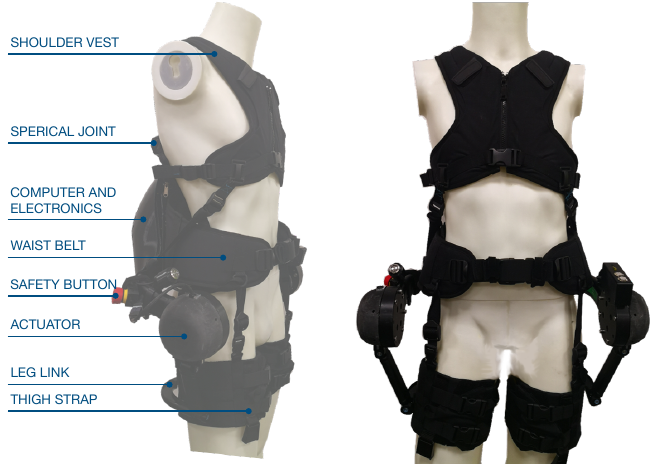
Figure 1. The XoTrunk exoskeleton prototype (see [42] for more